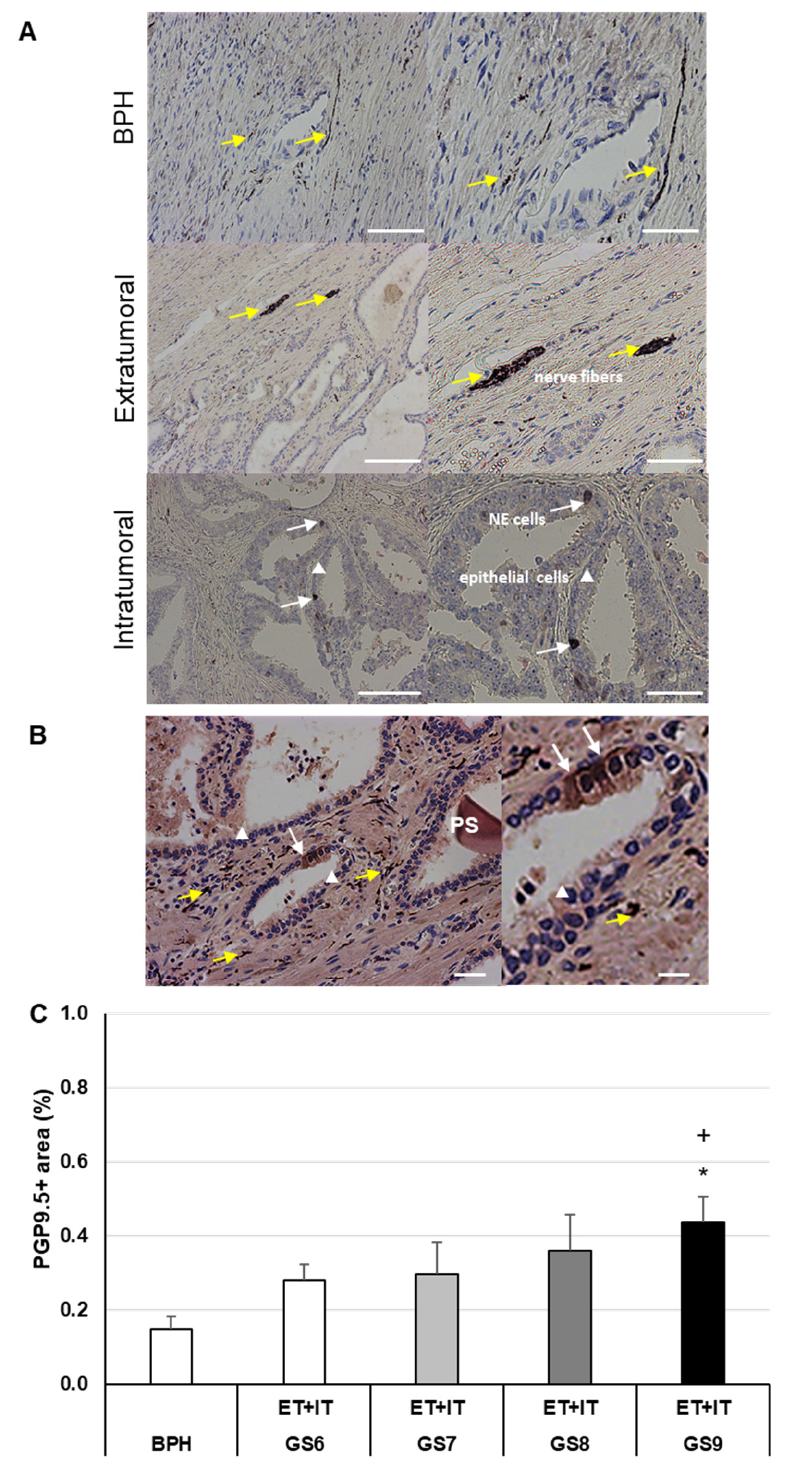
Figure 1. PGP9.5 (~UCHL1) IHC of human BPH and PCa. ( A ) Representative images of BPH and extratumoral [ET] or intratumoral [IT] PCa regions. ( B ) PGP9.5+ epithelial cells. Nerve fibers are marked with yellow arrows, PGP9.5+ neuroendocrine cells (NE) with white arrows, epithelial lining cells are indicated with a white triangle, and a prostate stone (PS) is also seen. ( C ) Percentage of PGP9.5+ area in BPH and PCa with different Gleason scores (GS). The data show means + SEM; significance: * p ≤ 0.05 vs. BPH; + p ≤ 0.05 vs. GS6. Scale bar from left to right ( A ) 200 and 100 µm; ( B ) 100 and 50 µm.